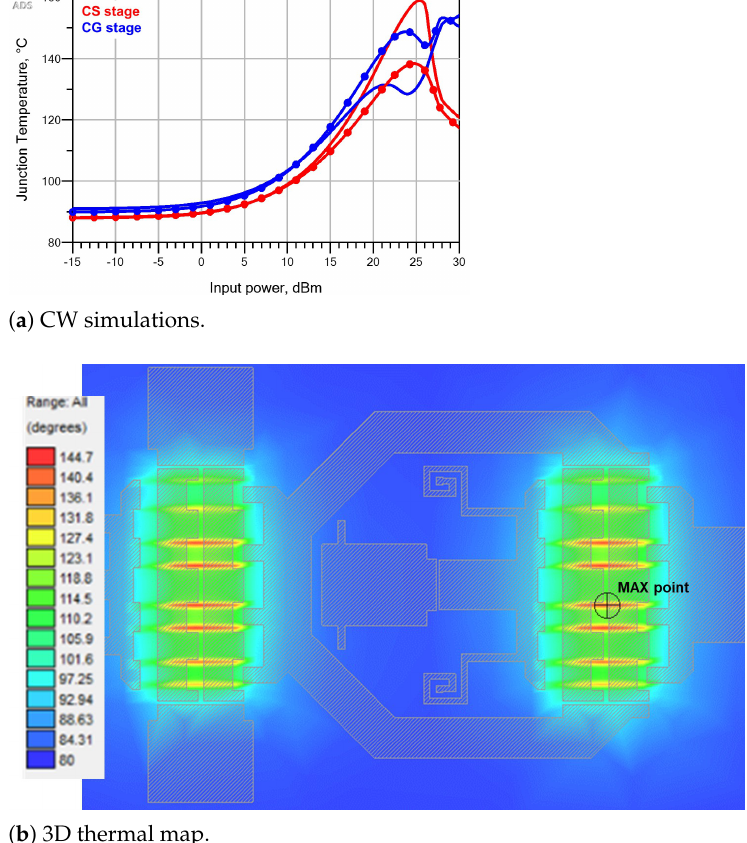
Figure 27. Thermal simulations of the L GS